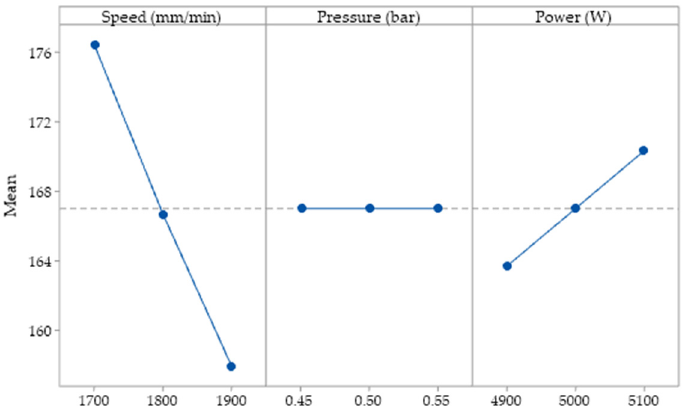
Figure 4. Main effects for linear energy.